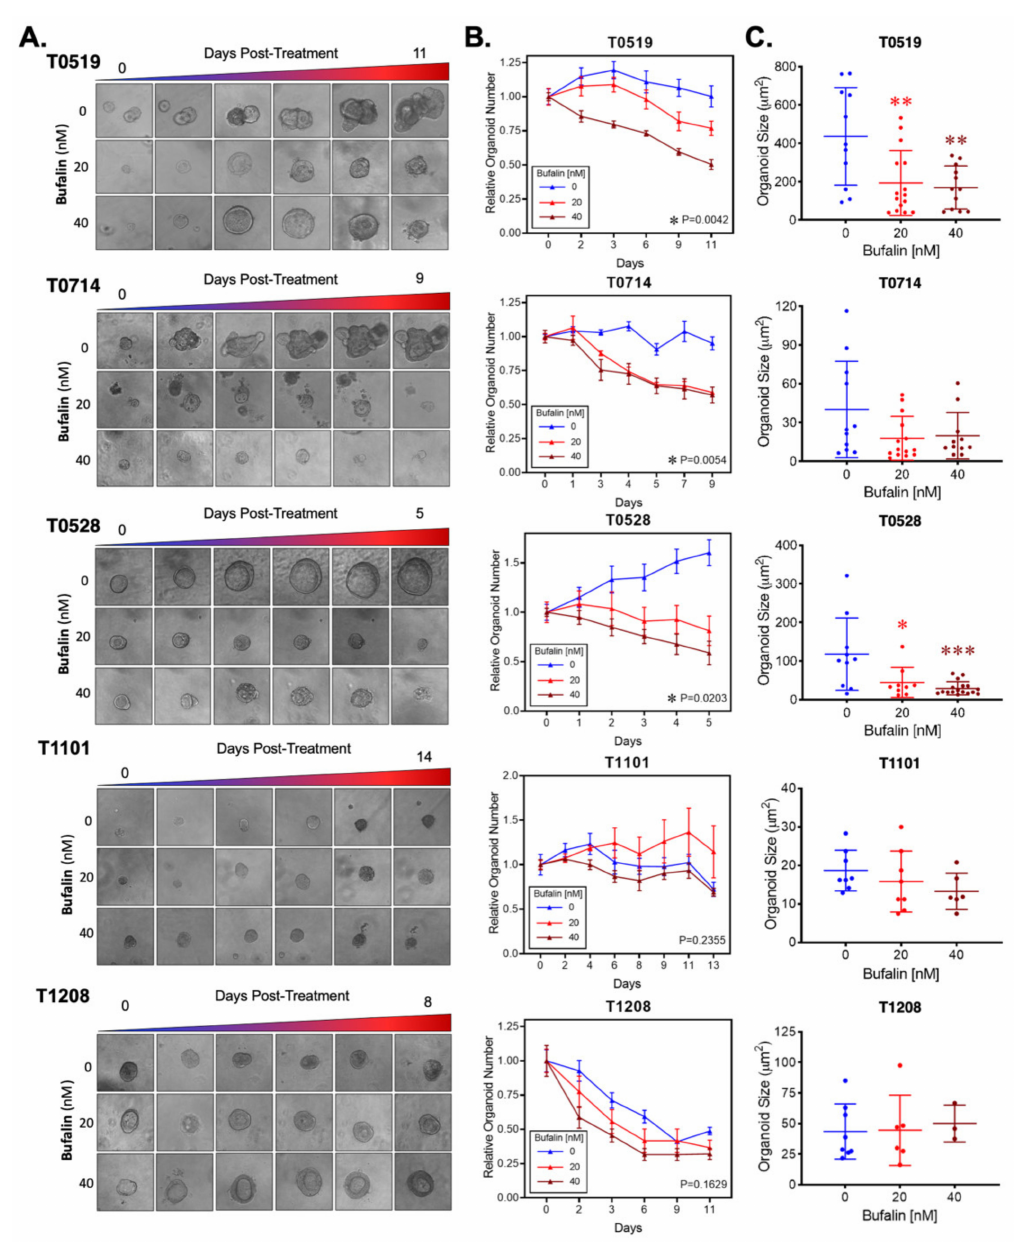
Figure 5. Bufalin inhibits tumorigenesis in organoids derived from patients with colorectal adenoma and adenocarcinoma. ( A ). Representative microscopy images showing the effect of 20 or 40 nM bufalin treatment on patient-derived organoids of colorectal adenoma (T0519), colon adenocarcinoma (T0528), and rectal adenocarcinoma (T0714, T1208, and T1101) patient-derived organoids. ( B ) Quantification of the time-dependent change in organoid number over the course of bufalin treatment in five PDOs demonstrating significant decreases in the number of organoids for T0519, T0528, and T0714. ( C ) Quantification of the final organoid sizes determined by microscopy measurements in the five PDOs, demonstrating a significant reduction in the size of T0519 and T0528, but no statistically significant reduction in T0714, T1208, and T1101. (* p < 0.05, ** p < 0.01, *** p < 0.001). (Images at 20 ×